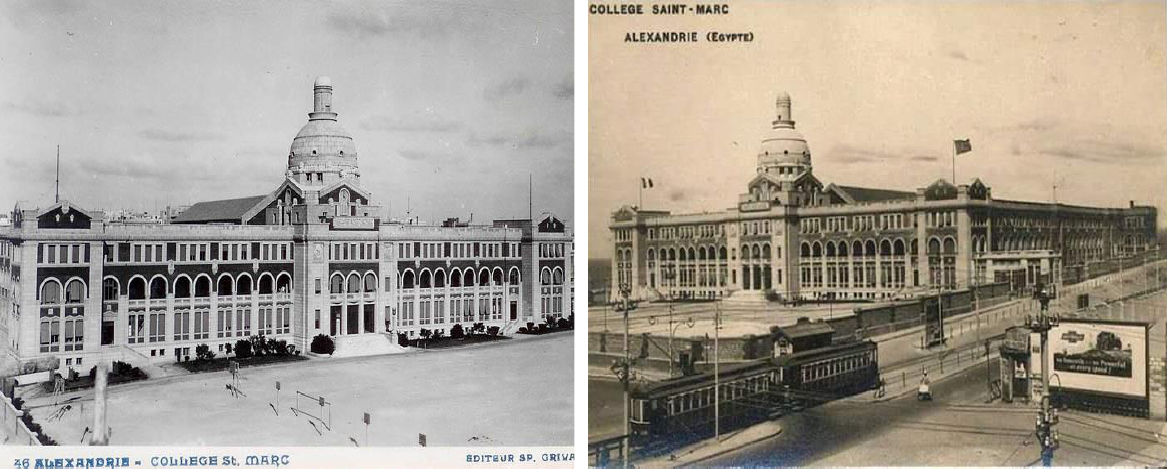
Figure 7: Collège Saint Marc, El Shatby - Alexandria (AAHA index,